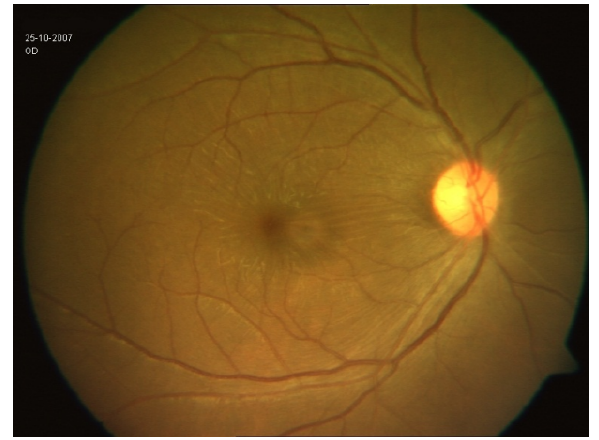
Figure 2: Color fundus photograph of the eye at presentation. Internal limiting membrane (ILM) folds over the macula and mild disc hyperemia are noteworthy.